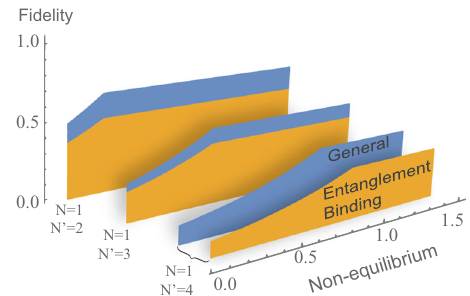
Fig. 3 | Entanglement binding machines vs. general quantum machines. The fi gure illustrates the accessible regions for the cloning fi delity when generating N 0 =2,3,4outputcopiesfrom N =1inputcopy,inthecaseofqubitswithdegenerate Hamiltonian. The values of the fi delity in the blue region are attainable by general quantum machines, while the values in the orange region are attainable by entan- glement binding machines. The difference between the two regions indicates a thermodynamic advantage of general quantum machines over all classical